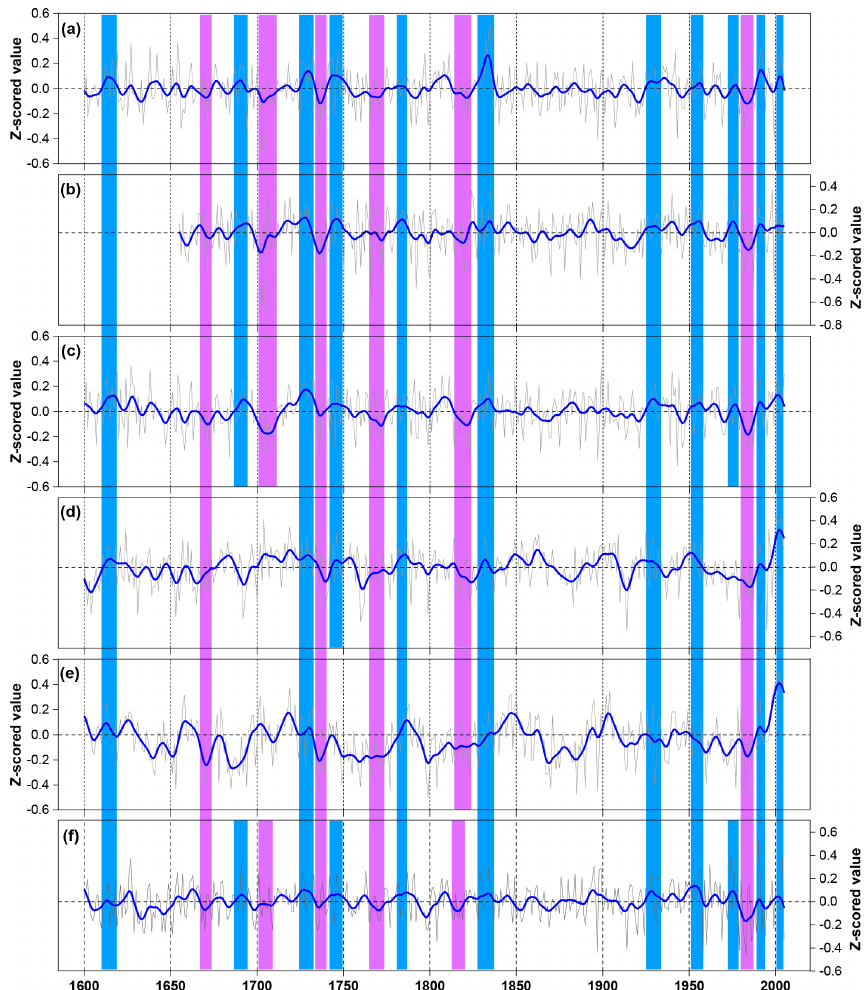
Figure 7. Comparisons of the hydroclimatic reconstructions in different studies. (a) The NGS precipitation reconstruction in the present study. (b) The current-year March–May average Palmer Drought Severity Index (PDSI) reconstruction in Fan et al. (2008). (c) The recon- struction of average PDSI from May of the previous year to April of the current year in Fang et al. (2010). (d) The current-year May–June average PDSI reconstruction in Zhang et al. (2015). (e) The current-year April–June average PDSI reconstruction in Li et al. (2017). (f) Drought series extracted from Asian Monsoon Atlas from the nearest point (Cook et al., 2010). The blue and purple bars show the common wet and dry periods of the different reconstructions,